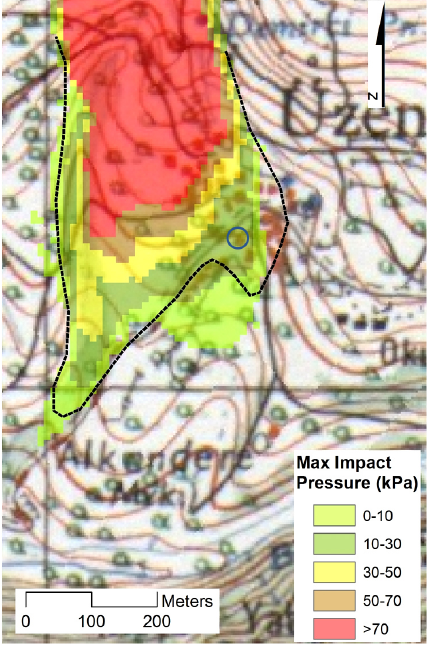
Fig. 10. Avalanche impact pressure at damaged mosque area (mosque indicated with blue circle, see Fig. 4; dashed black line indicates the outline of observed avalanche).